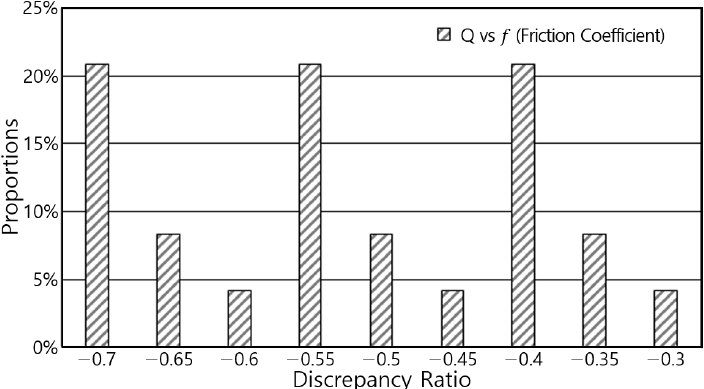
Figure 12. The discrepancy ratio for f and Q calculated using Babaeyan-Koopaei’s data.